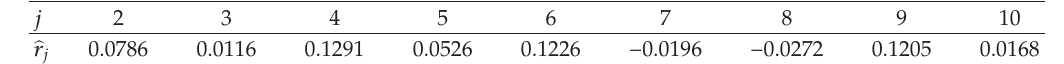
Table 2: Maximum likelihood estimates of r j for j (cid:5) 2 ,..., 10.